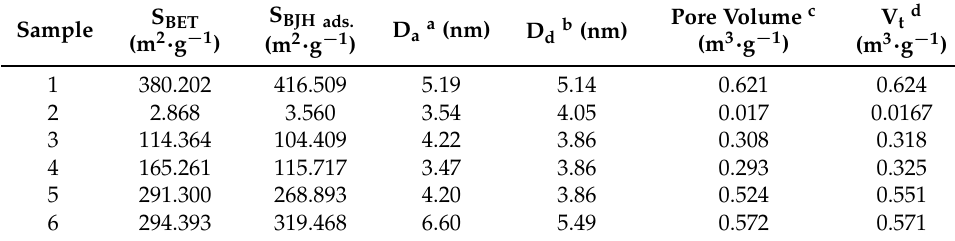
Table 3. Textural properties of the C18-modified silica hybrids from N 2 adsorption-desorption isotherms.